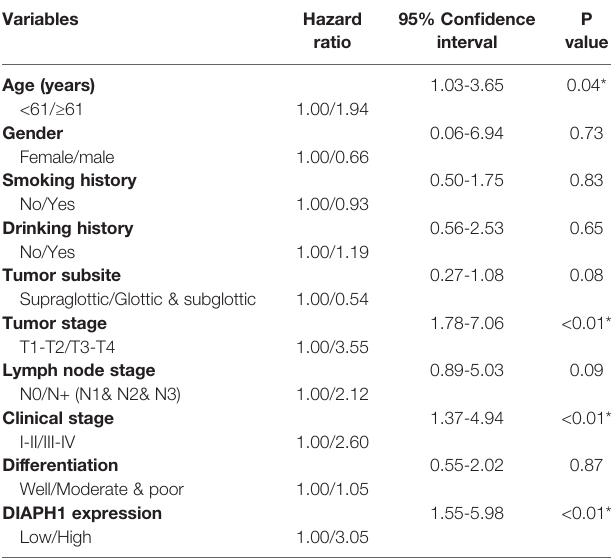
TABLE 3 | Univariate analysis of the demographics and clinical characteristics related to overall survival (*p<0.05). Variables